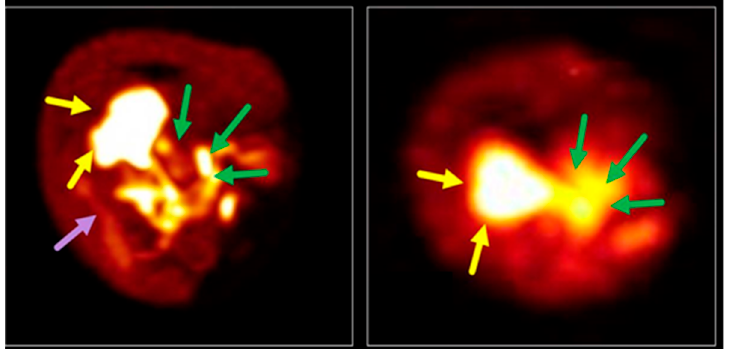
Figure 8. Liver accumulation (yellow arrows) and biliary excretion into the duodenum (green arrows) of 68 Ga-TEtOHB-DAZA ( left ) compared to 99m Tc-EHIDA ( right ) in an in ovo model. 68 Ga-TEtOHB-DAZA also shows slight accumulation in the kidneys (purple arrow)